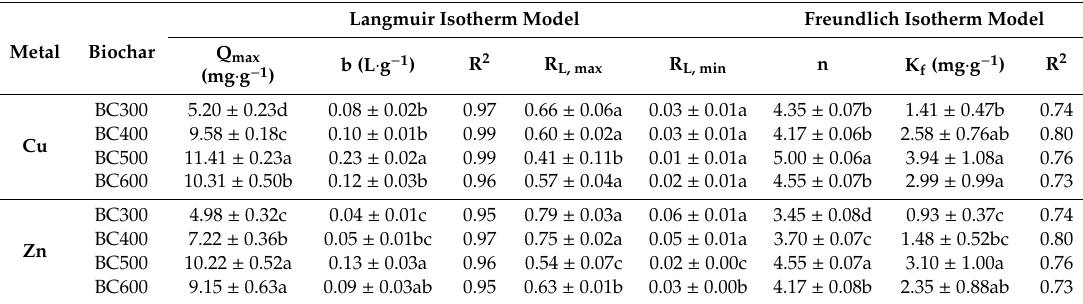
Table 4. Langmuir and Freundlich isotherm parameters and correlation coe ffi cients for Cu(II) and Zn(II) absorption by BCs.